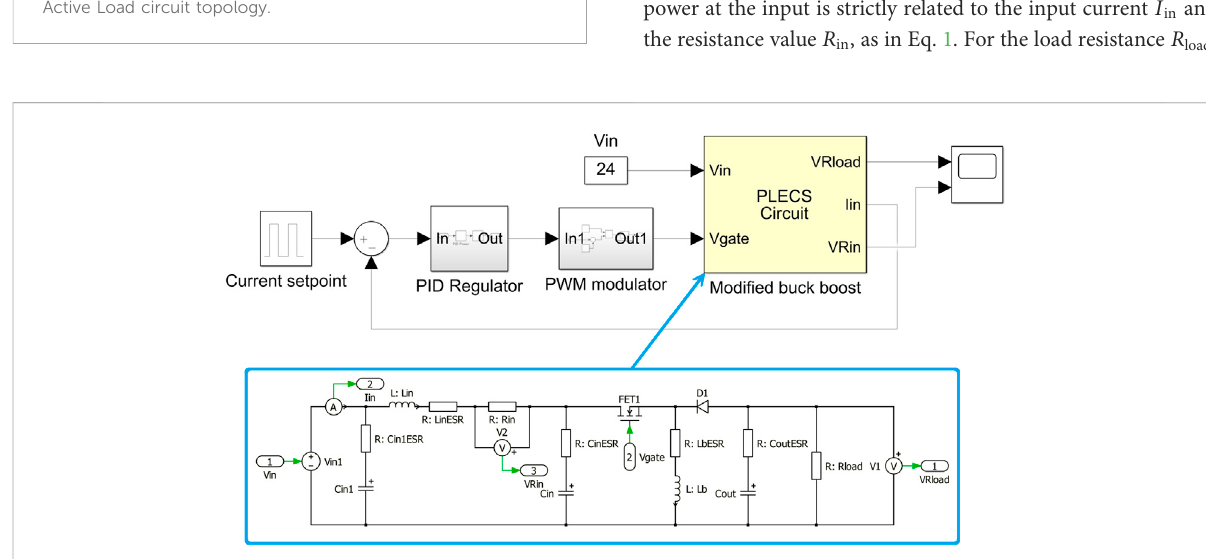
FIGURE 2 Active Load Simulation Model. The PLECS subsystem with the circuit model is